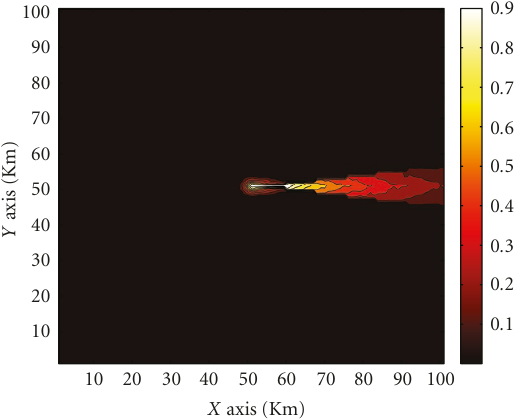
Figure 6: A directional antenna’s detection probability map.